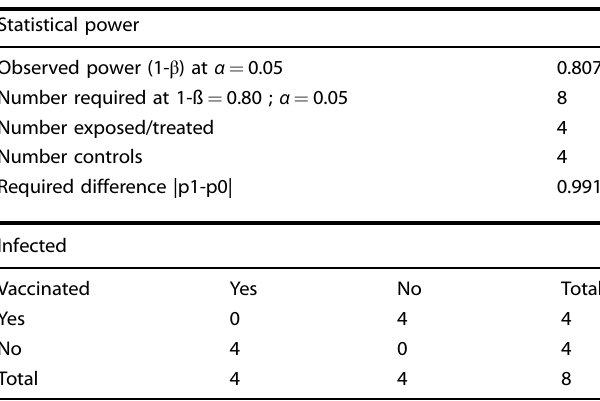
Table 1. Statistical power calculation and sample size determination using 2 × 2 contingency table (right) and Fisher ’ s exact test. Statistical